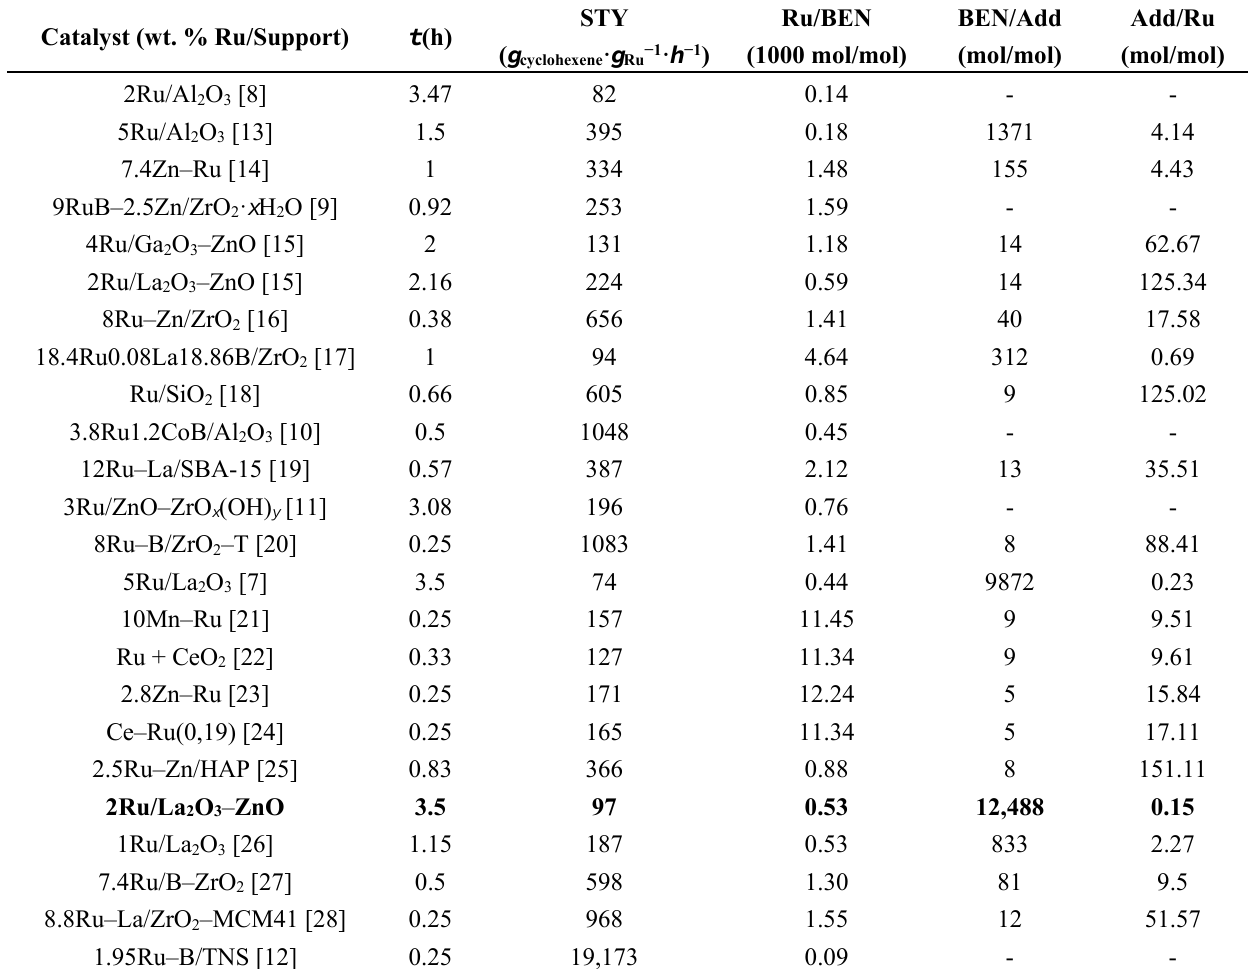
Table 1. Overview of the catalyst systems described in the literature. Catalyst (wt. %